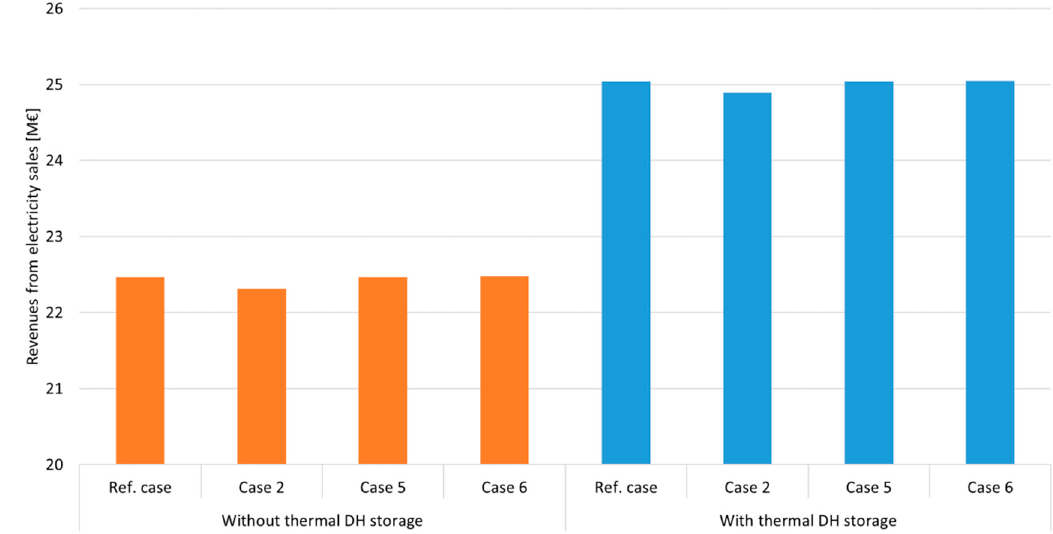
Figure 9. Revenues from electricity sales in the reference case and in the DR Cases 2, 5 and 6 with and without HWT in the system.